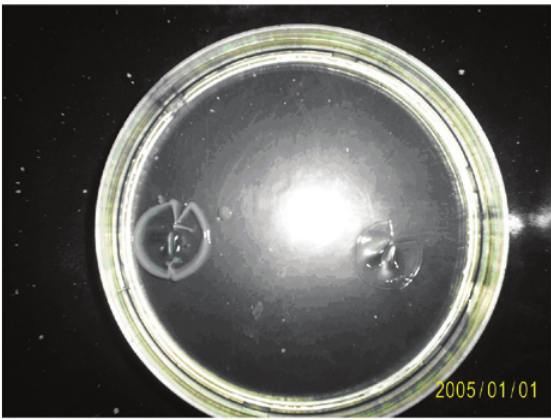
Figure 1: Bacterial growth around one sample (on the left) of a blister packed Hydron contact lens (expiry date 2003). Notice that the sample on the right remains uncontaminated. (Please ig- nore the date due to incorrect camera settings.)